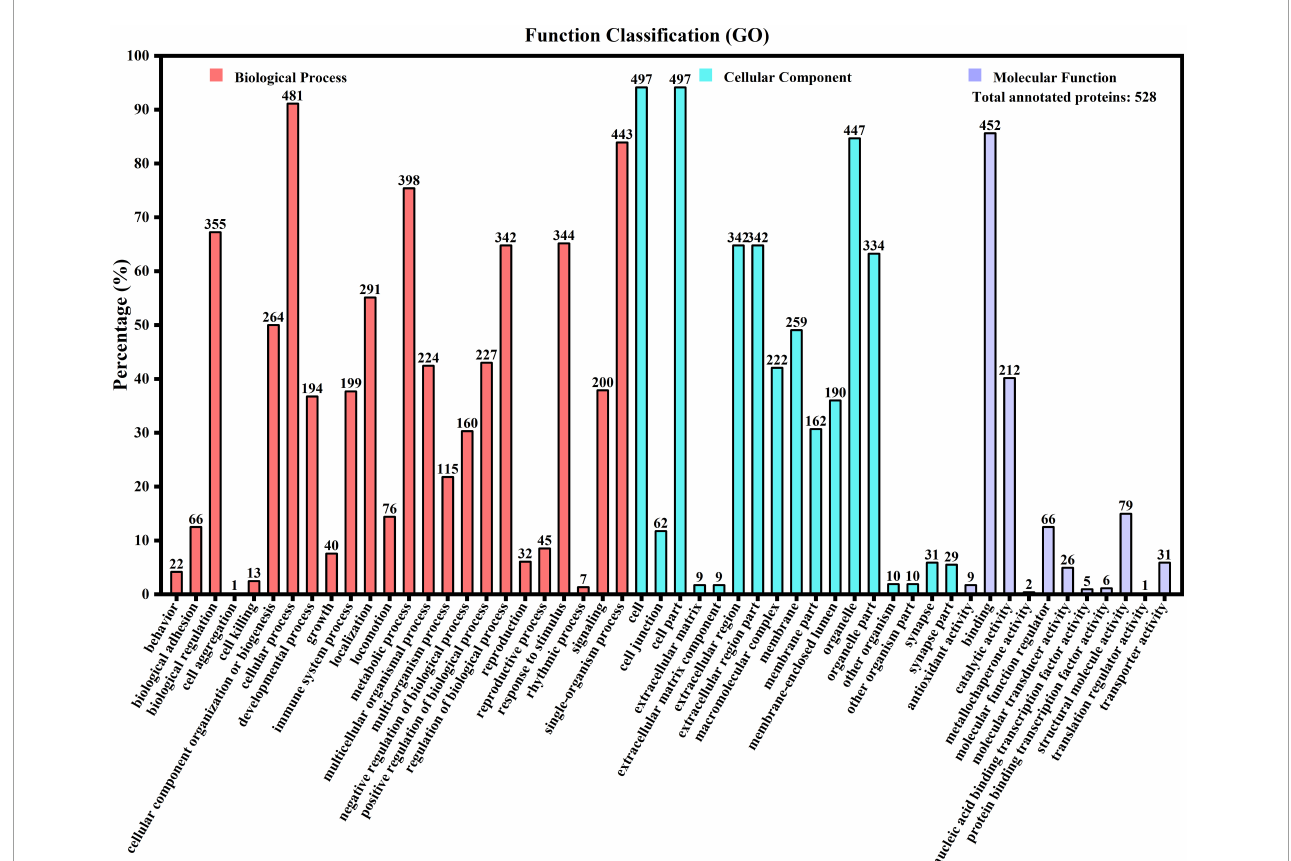
FIGURE1 Gene Ontology function annotation of human milk caseins from Korean and Han ethnic groups in China.